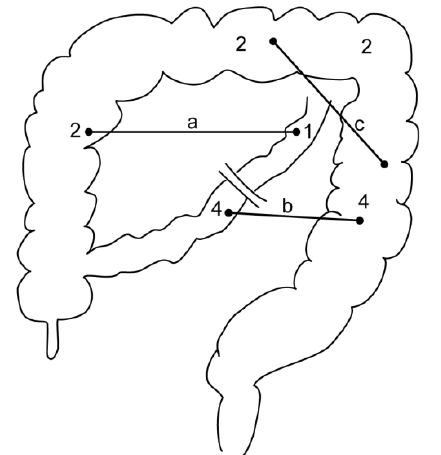
Figure 4: Graphic illustration of the position of the strictures (n=15) in 12 infants, of which 3 had two strictures each with their respective position marked by bars